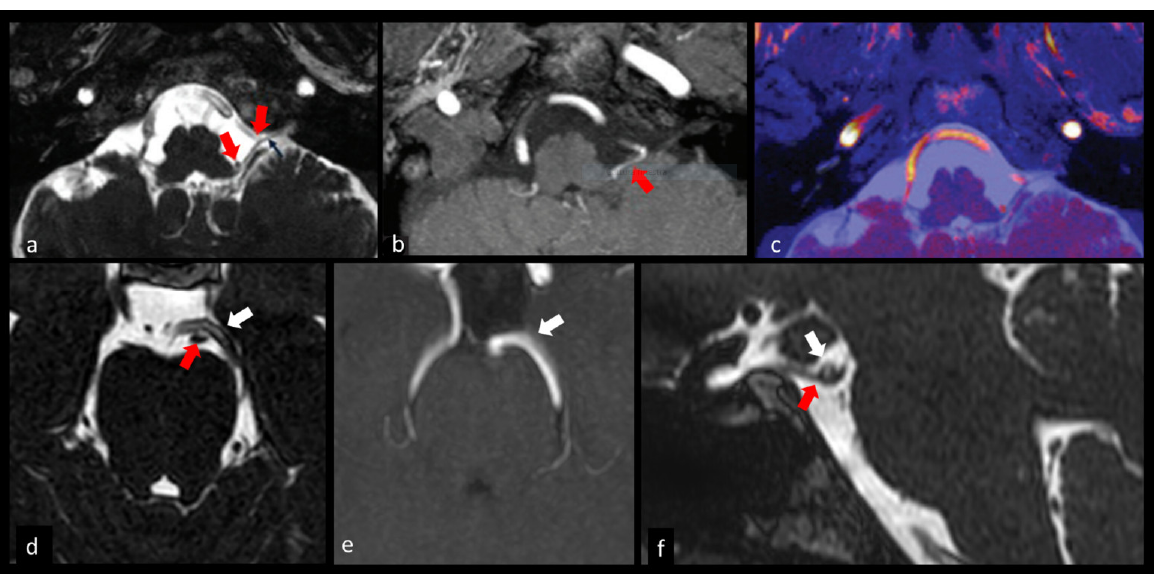
Figure 3. Neurovascular conflicts. ( a – c ) 71-year-old female with a 3-year history of intense pain localized in the pharynx and the posterior portion of the tongue. Axial 3D CISS ( a ) and 3D time-of- flight magnetic resonance angiography (3D TOF MRA) ( b ) show that the left posteroinferior cerebellar artery (red arrows) impacts the IX, X and XI cranial nerves at the root entry zone and along the intracisternal nerve tract. Postprocessed fused 3D CISS-TOF image ( c ) simultaneously displays the offending vessel (red color) and nerves (blue color). These images were released under CC license (with unrestricted use) (Alafaci et al. [25]). ( d – f ) Transient left third nerve palsy presumably caused by neurovascular compression. Axial ( d ) and sagittal ( f ) 3D CISS images show a close relationship between third nerve (red arrow) and posterior cerebral artery (white arrow) on the left side, with mild inferior displacement of the third nerve. 3D-TOF with maximum intensity projection (MIP) reconstructions ( e ) depicts the course of left posterior cerebral artery well. The patient spontaneously recovered from symptoms two days after the execution of magnetic resonance imaging (MRI).